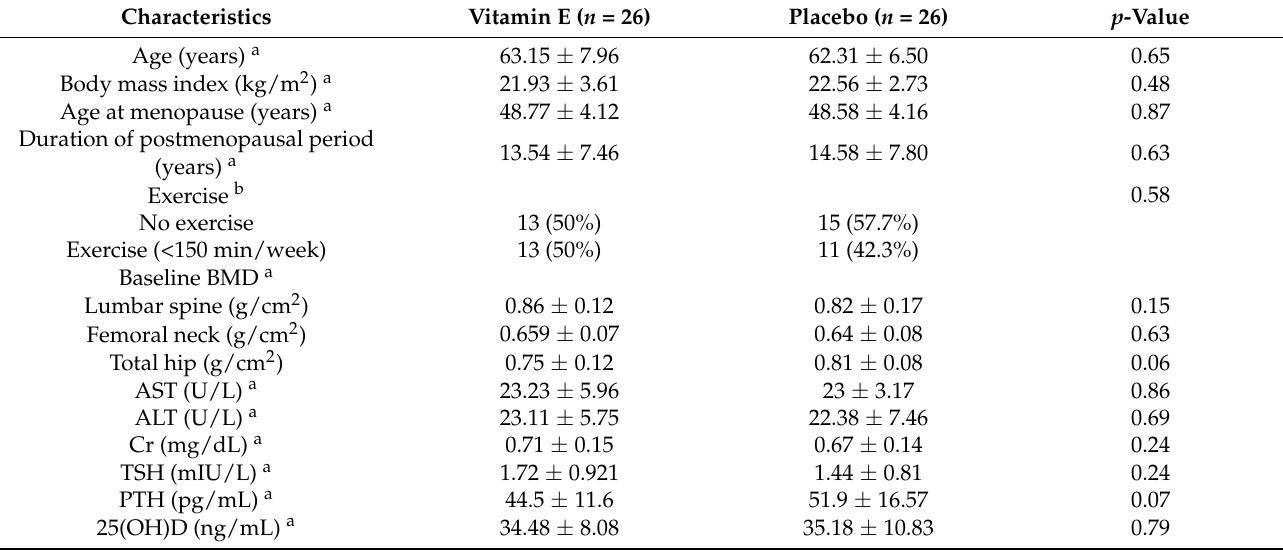
Figure 1. Protocol flow diagram according to CONSORT flow diagram 2010. Figure 1 . Protocol flow diagram according to CONSORT flow diagram 2010 . Table 1. Baseline characteristics of the Table 1 . Baseline characteristics of the participants .